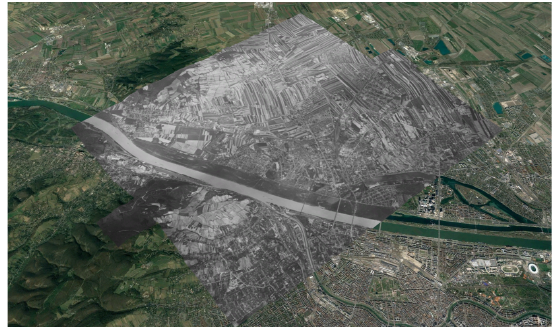
Figure 8. Georeferenced and orthorectified images over Vienna (Austria) produced from the 1958 dataset, overlaid in Google Earth for visual quality control.